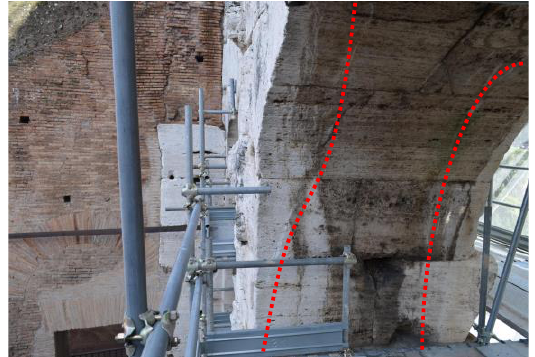
Figure 19 . Vertical cracks, highlighted in red, in the internal part of the arch between column 4 and 3. A core drilling, performed in column 3, showed that the rebars were corroded not only in the external, but also in the inside.